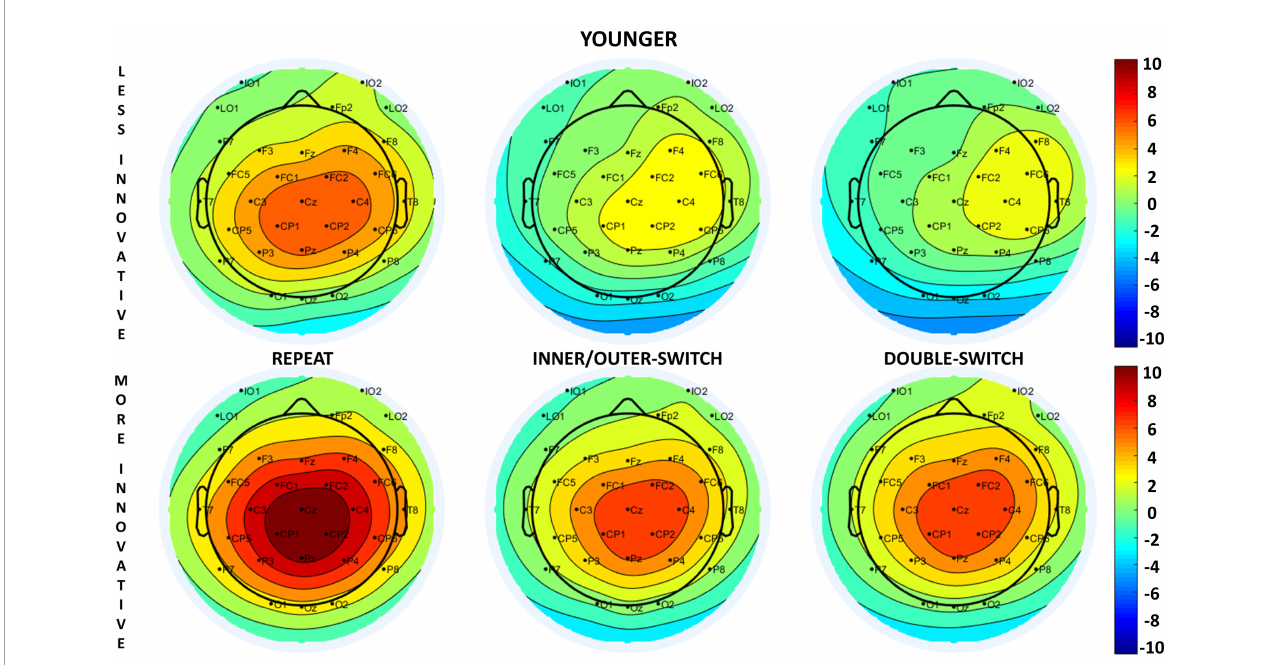
FIGURE6 Scalp distributions of the target-locked P3b component at 600 ms (relative to the presentation of the target stimuli) for each Switch-type in the younger innovative creativity